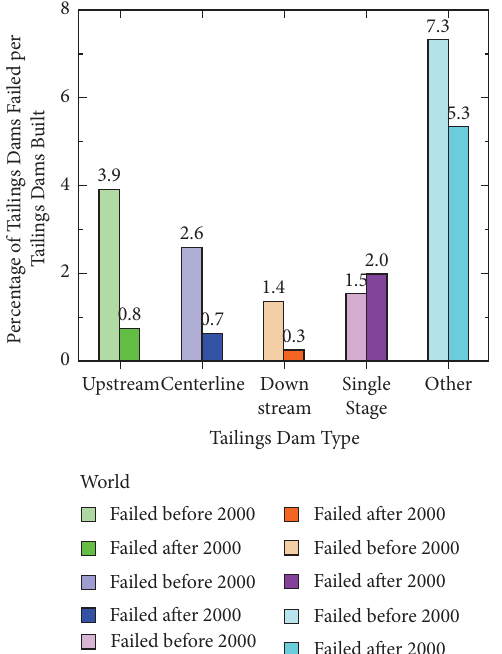
Figure 5: Percentage of tailings dams failed per tailings dams built in the world, before and after 2000, according to dam type (data from GRID-Arendal [25], Bowker [22], and Torrez-Cruz